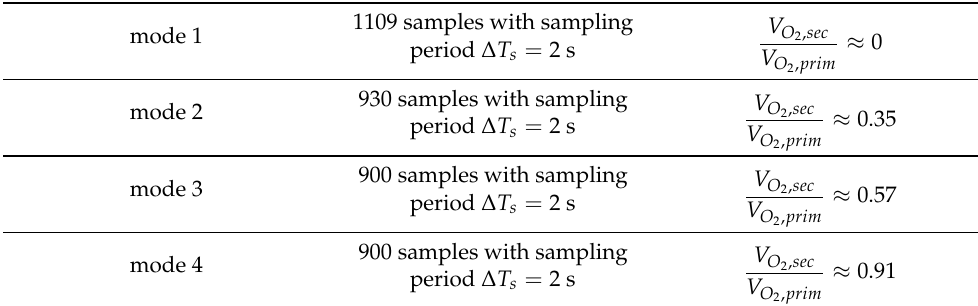
1109 samples with sampling period ∆ T s = 2 s 930 samples with sampling period ∆ T s = 2 s 900 samples with sampling period ∆ T s = 2 s 900 samples with sampling period ∆ T s = 2 s